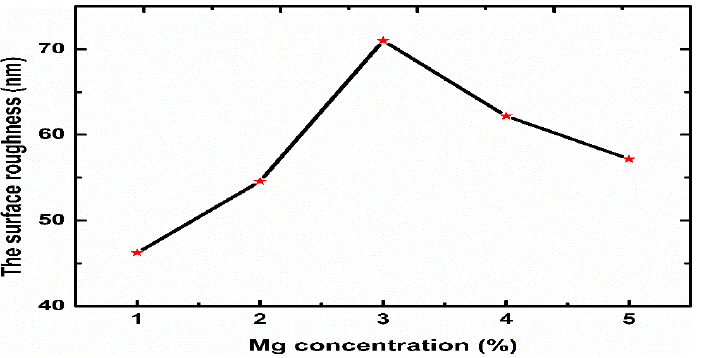
Figure 6. The surface roughness of the prepared ZnO nanorods as a function of the Mg concentra-